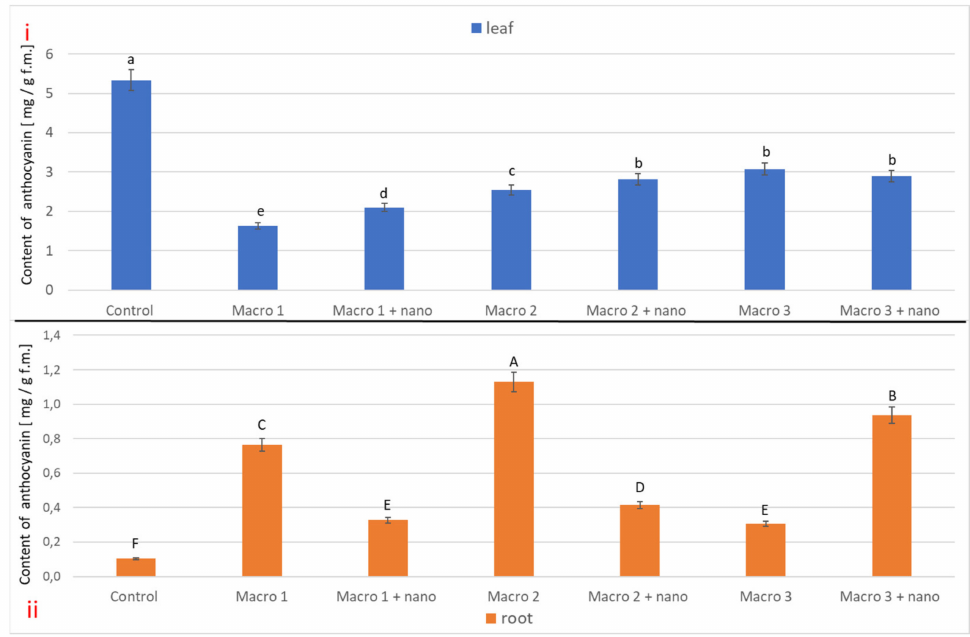
Figure 5. The content of anthocyanin [mg g − 1 fresh weight] in the shoots ( i ) and roots ( ii ) of plants grown in soil supplemented macronutrients or macronutrients and nanoparticles. Vertical bars represent the mean values (n = 5) ± standard deviations. Different letters indicate significant difference at p < 0.05 by LSD